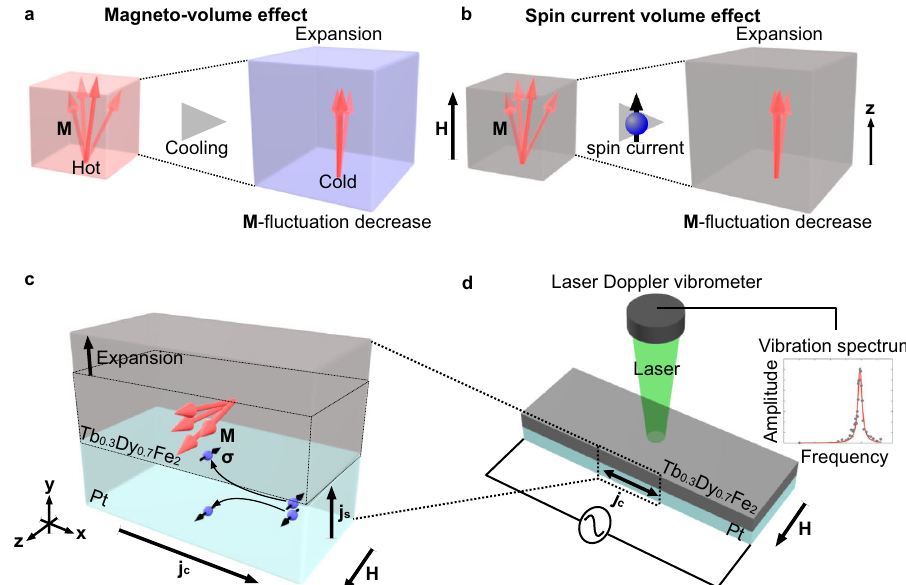
Fig. 1 Concept of spin current volume effects (SVEs). a A schematic illustration of the magneto-volume effect (MVE). A ferromagnet expands (shrinks) via the spin-lattice coupling when spin fl uctuation in the magnet decreases (increases) due to the magnetic fi eld application or temperature modulation. The left (right) panel shows the ferromagnet at higher (lower) temperature. b A schematic illustration of SVE. The volume of a ferromagnet can be tuned by spin current injection. The left (right) panel shows the ferromagnet before (after) the spin current injection. c A schematic illustration of SVE induced by the spin Hall effect (SHE) in a Pt/Tb 0.3 Dy 0.7 Fe 2 bilayer system. H , M , j c , j s , and σ denote the magnetic fi eld, magnetization of the Tb 0.3 Dy 0.7 Fe 2 fi lm, a charge current, a spin current, and the spin polarization vector of j s , respectively. When j c fl ows in the + x direction in the Pt fi lm, j s with σ is injected into the Tb 0.3 Dy 0.7 Fe 2 fi lm, and M fl uctuation in the Tb 0.3 Dy 0.7 Fe 2 fi lm decreases, causing the volume expansion via the spin-lattice coupling. The volume expansion should accompany a thickness change of the Tb 0.3 Dy 0.7 Fe 2 fi lm due to the in-plane constraints of the fi lm on a Si substrate. d A measurement setup in the present study. An a.c. spin current is injected into the Tb 0.3 Dy 0.7 Fe 2 fi lm via the SHE by applying j c to the Pt fi lm, and the mechanical vibrational spectrum for the sample surface is obtained by laser Doppler